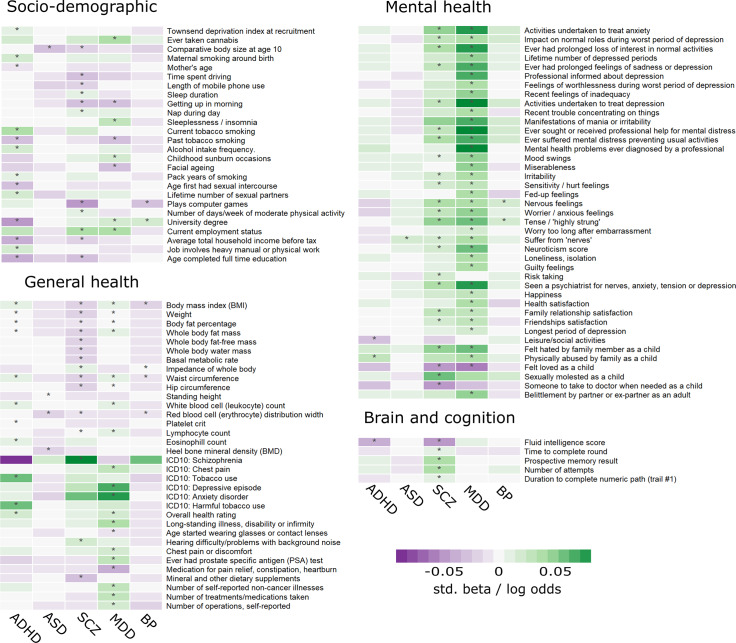
Cross-disorder comparison.Shown are standardized log odds (upper section in each panel) or standardized beta-values (lower section of each panel) of all outcomes associated with polygenic risk scores for either attention deficit/hyperactivity disorder (ADHD), autism spectrum disorder (ASD), schizophrenia (SCZ), major depressive disorder (MDD) or bipolar disorder (BP) at p<2.55x10-6 as indicated by stars (*). For outcomes categorized as multi-category, only one category is displayed. Only associations with anthropometric measures of the right side of the body are shown. Estimates were generated by PHESANT. Results for continuous outcomes (std. beta) are the standard deviation change of inverse-rank normal transformed outcome per 1 SD higher PRS.